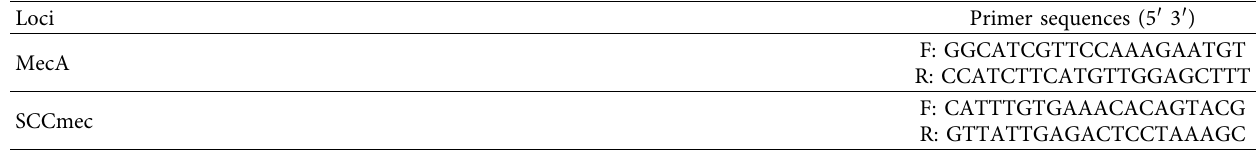
Table 2: Primer sets used to characterize methicillin-resistant Staphylococcus aureus